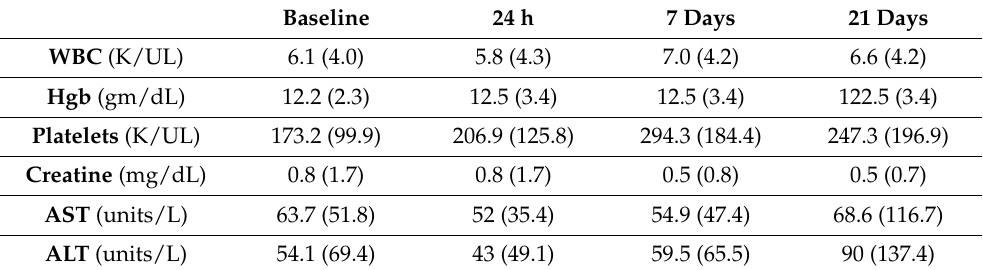
Table 2. Safety laboratory tests baseline to day 21 (mean + SD).